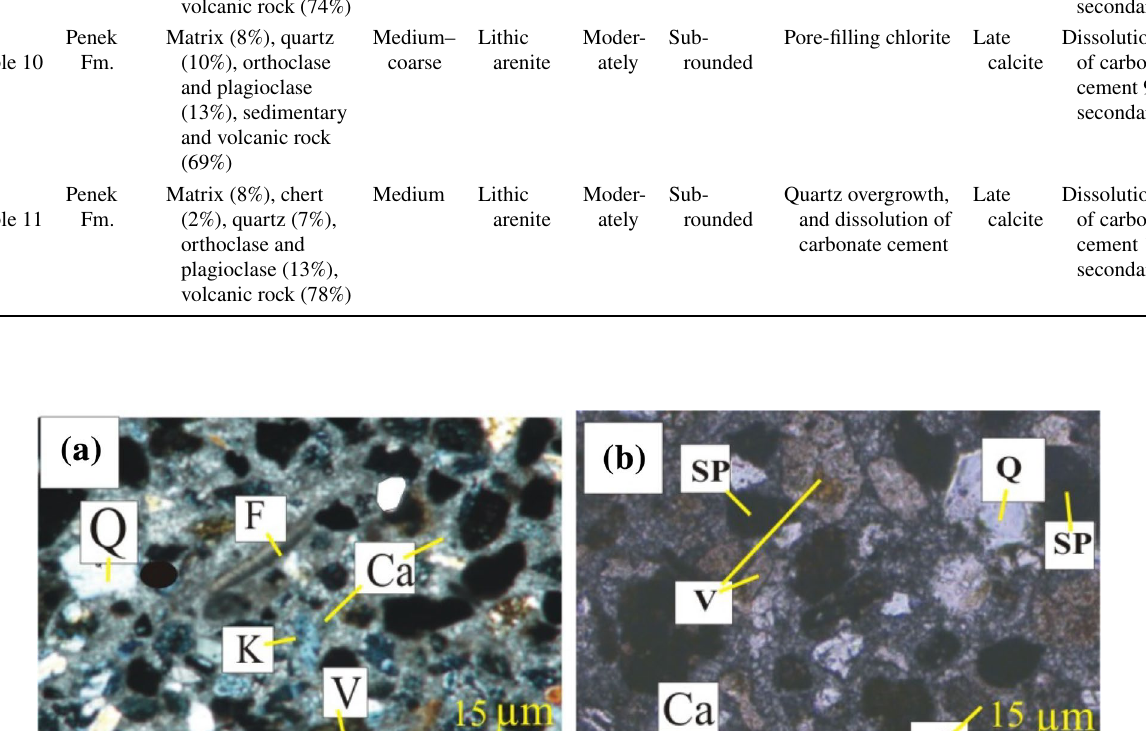
packed framework grains of sedimentary (S) and volcanic (V) rock fragment] and Q quartz are observed in the photo, depth: 2368